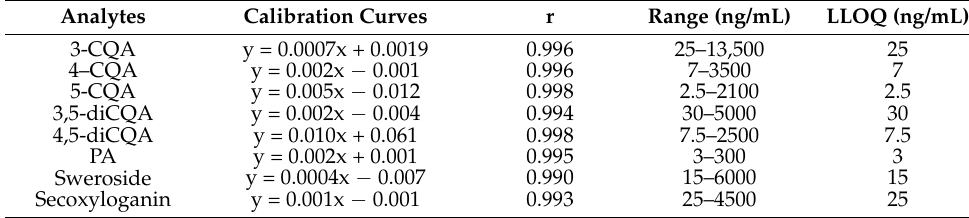
Table 2. The regression equations, linear range, and LLOQs for the eight compounds.